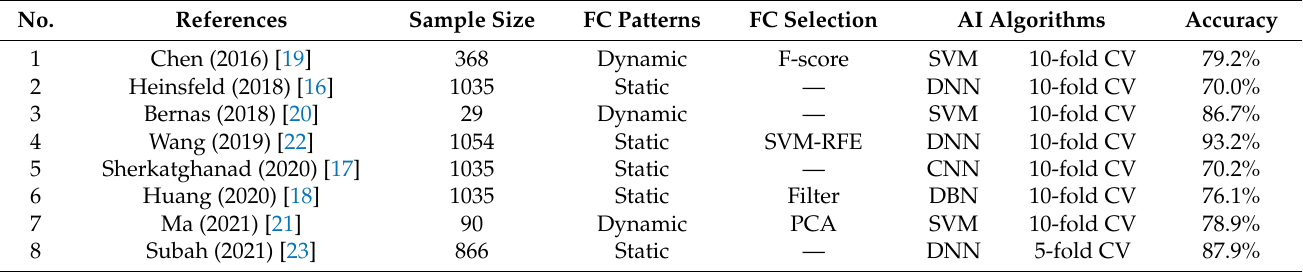
Table A1. Summary of previous AI algorithms in ASD classification using ABIDE rs-fMRI data.